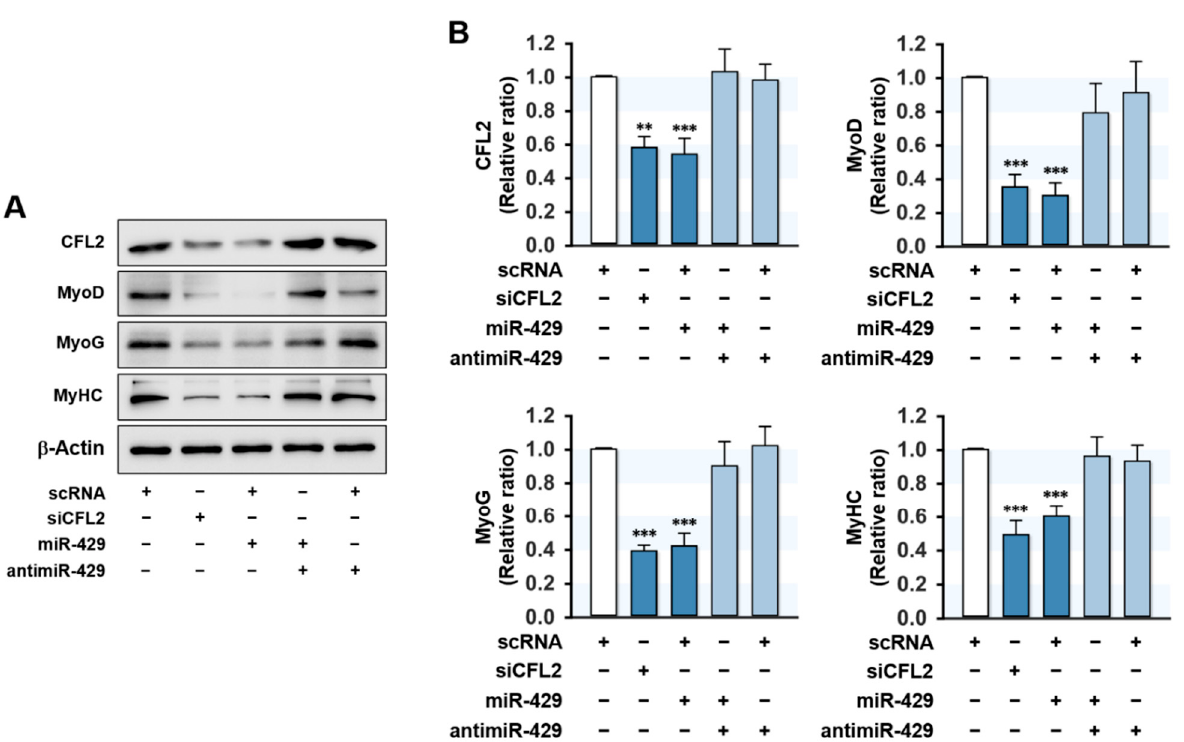
Figure 5. MiR-429-3p mimic suppressed myogenic factor expression. Cells were transfected with 200 nM of scRNA, siCFL2, miR-429-3p mimic, or antimiR-429-3p and were allowed to differentiate for three days. ( A ) Representative immunoblots showing the expressions of CFL2, MyoD, MyoG, and MyHC. ( B ) Quantitative analysis of CFL2 and myogenic factors (MyoD, MyoG, and MyHC) protein levels. Immunoblot results are shown as relative ratios versus scRNA controls. All results are presented as means ± SEM ( n > 3), and levels of significance as ** p < 0.01; *** p < 0.001 vs. scRNA.